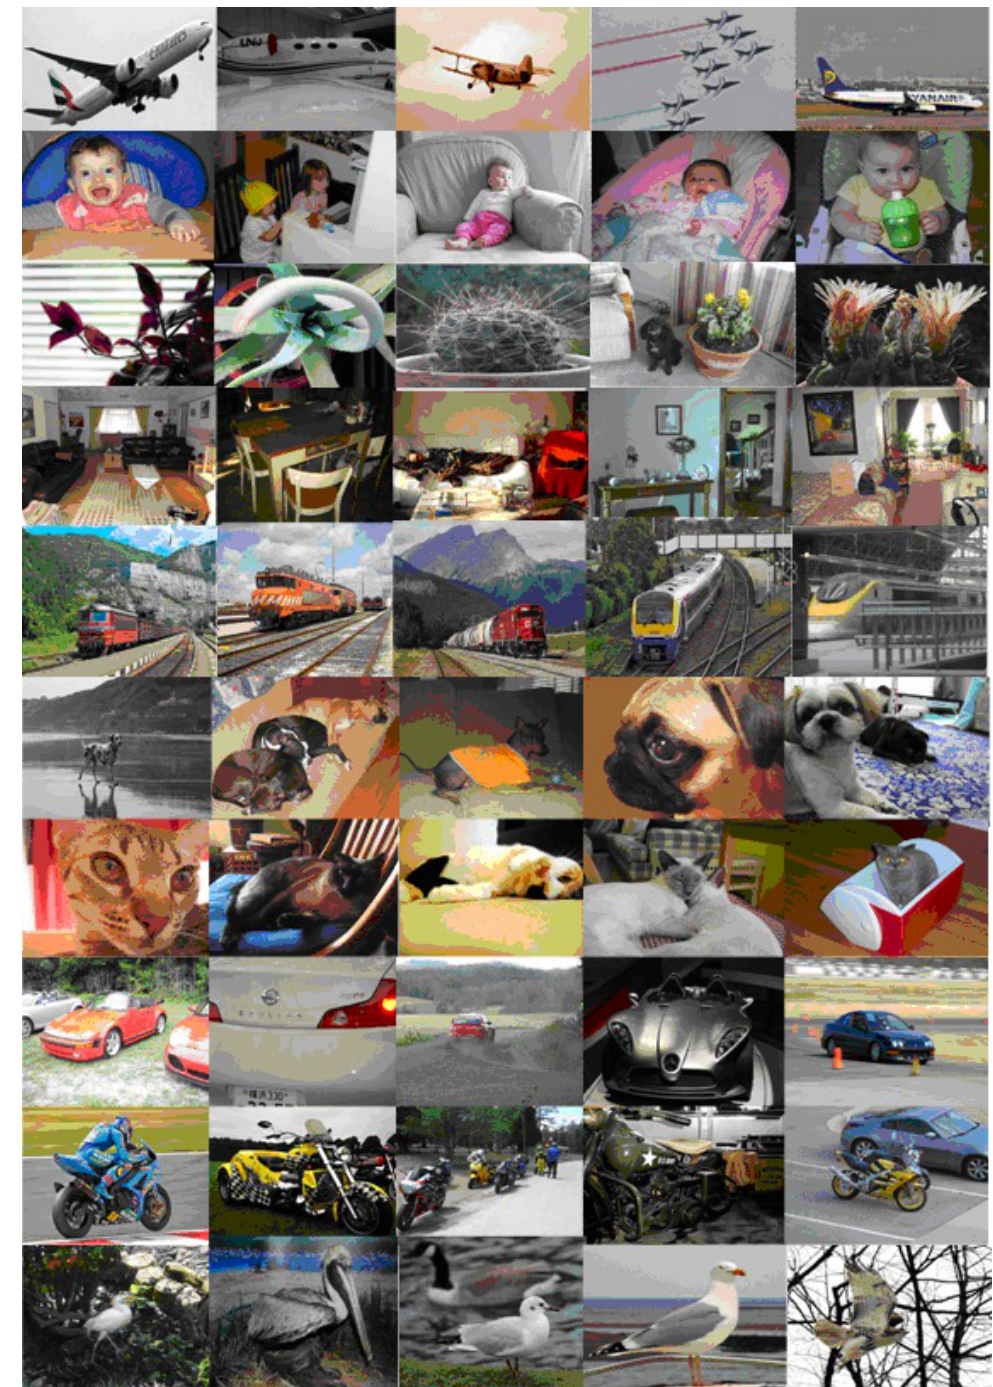
Figure 10. 50 images from the VOC data